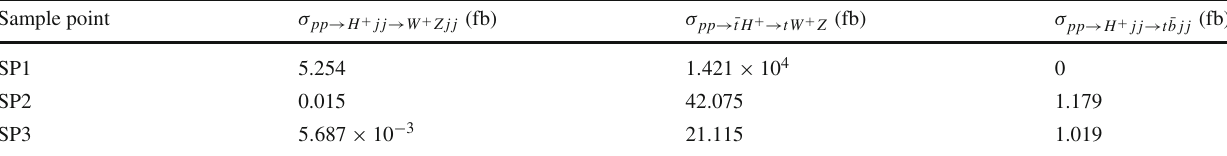
Table 4 Cross sections of processes (a), (b), (c) at 100 TeV FCC-hh Sample